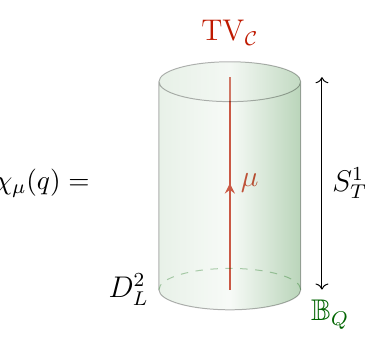
Figure 4 . The partition function of TV C on the solid torus D 2 and anyon µ in the middle. D 2 circle of size T . Since the boundary condition B Q is conformal, this partition function depends only on q = e − 2 π ( T/L )